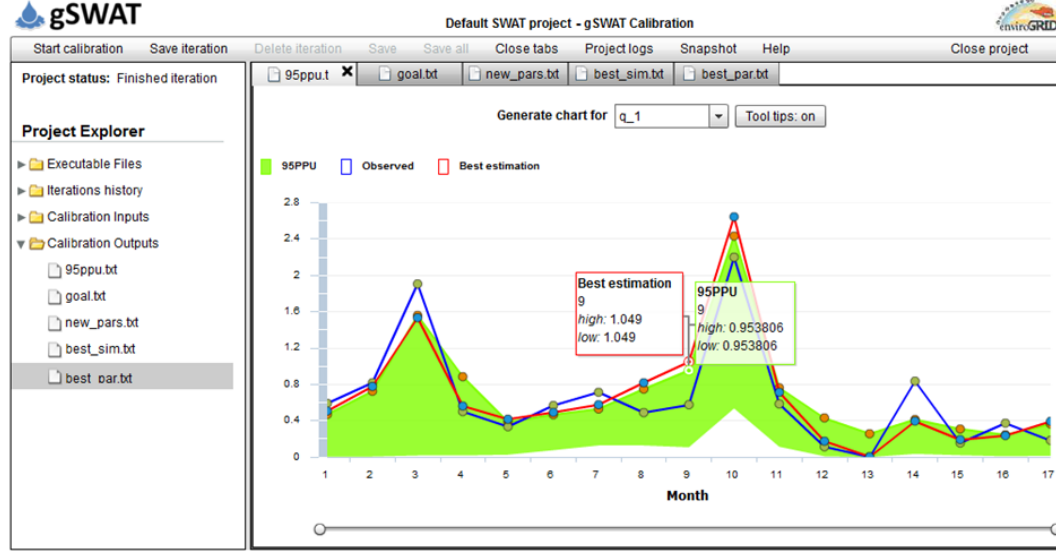
Fig. 9. Detailed visualization of the gSWAT calibration